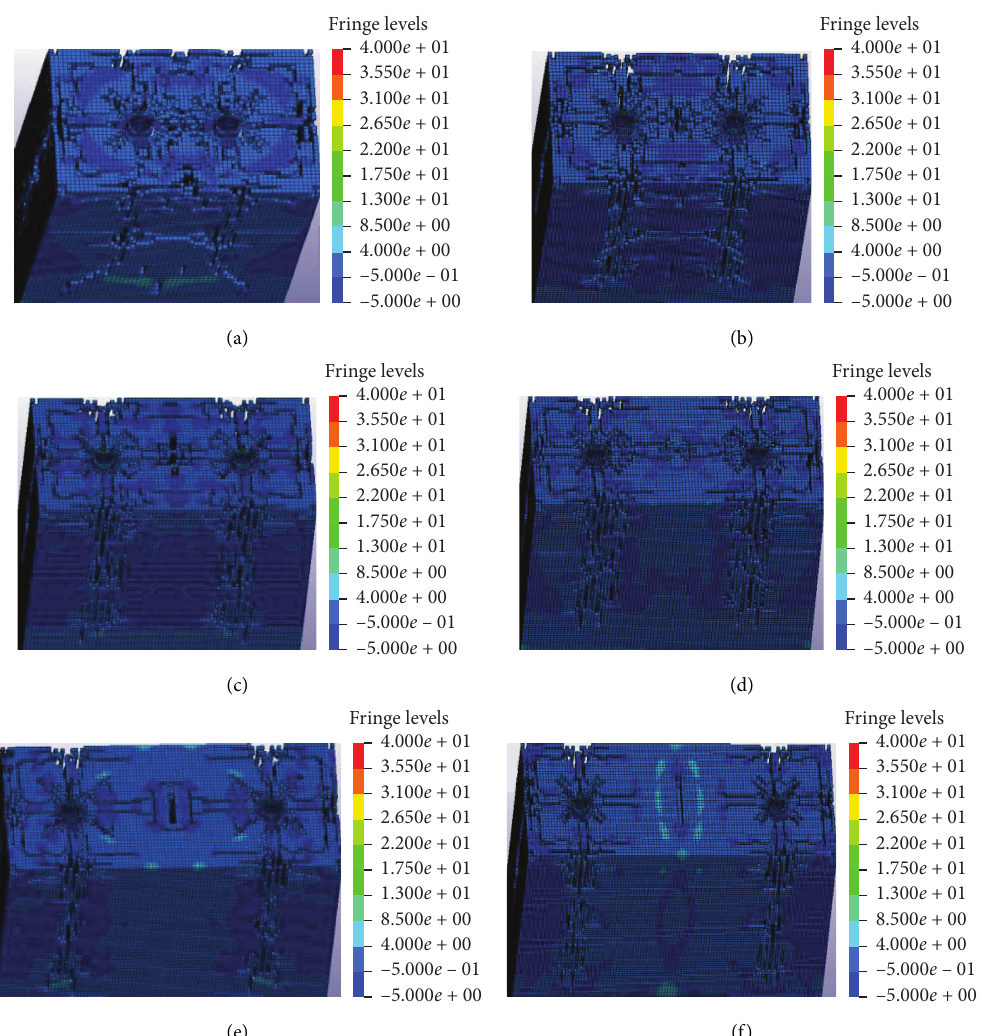
Figure 11: Simulation results of beams with different hole spacing when the aperture is 50 mm. (a) S � 200 mm. (b) S � 300 mm. (c) S � 400 mm. (d) S � 500 mm. (e) S � 600 mm. (f) S � 700 mm.